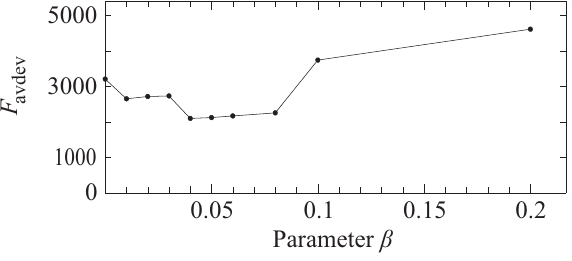
Figure 7. Average deviation F avdev versus parameter β .